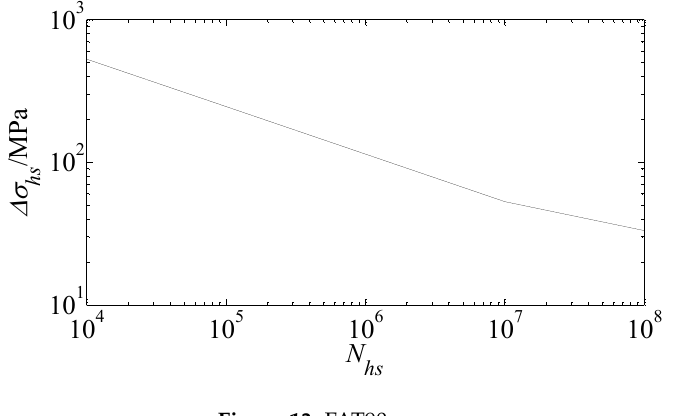
Figure 13. FAT90 curve. Table 4. Parameters for FAT90 curve.